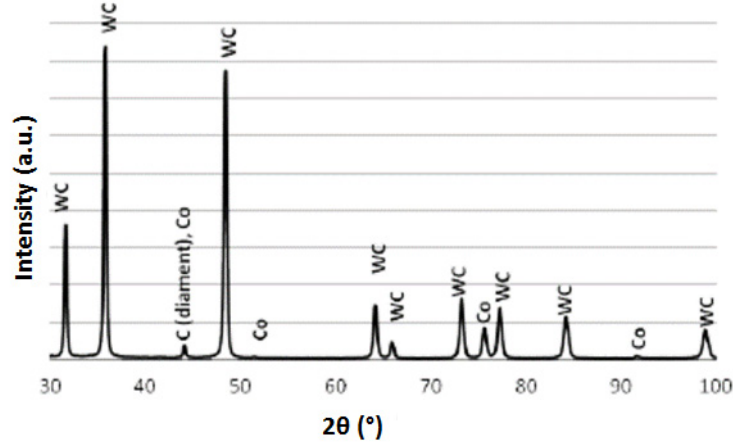
Figure 10. Diffraction analysis of WCCo/diamond composite (8–10 µm and 16–20 µm). The WC grain sizes of the obtained composites were analyzed with the particle size of the WC powder used to obtain the sinter. The average WC grain size in the solid com- posites was 0.4 ± 0.13 µm and is the same as the grain size of the starting powder. Thus, no WC grain growth occurred during the sintering process. Figure 11 presents histograms showing the distribution of WC grain size in the sintered composites and the starting powder.